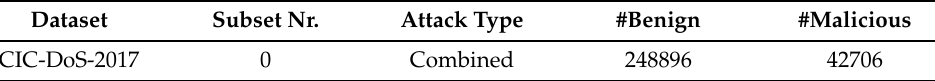
Table 2. CIC-DoS2017 Class Label Distribution.